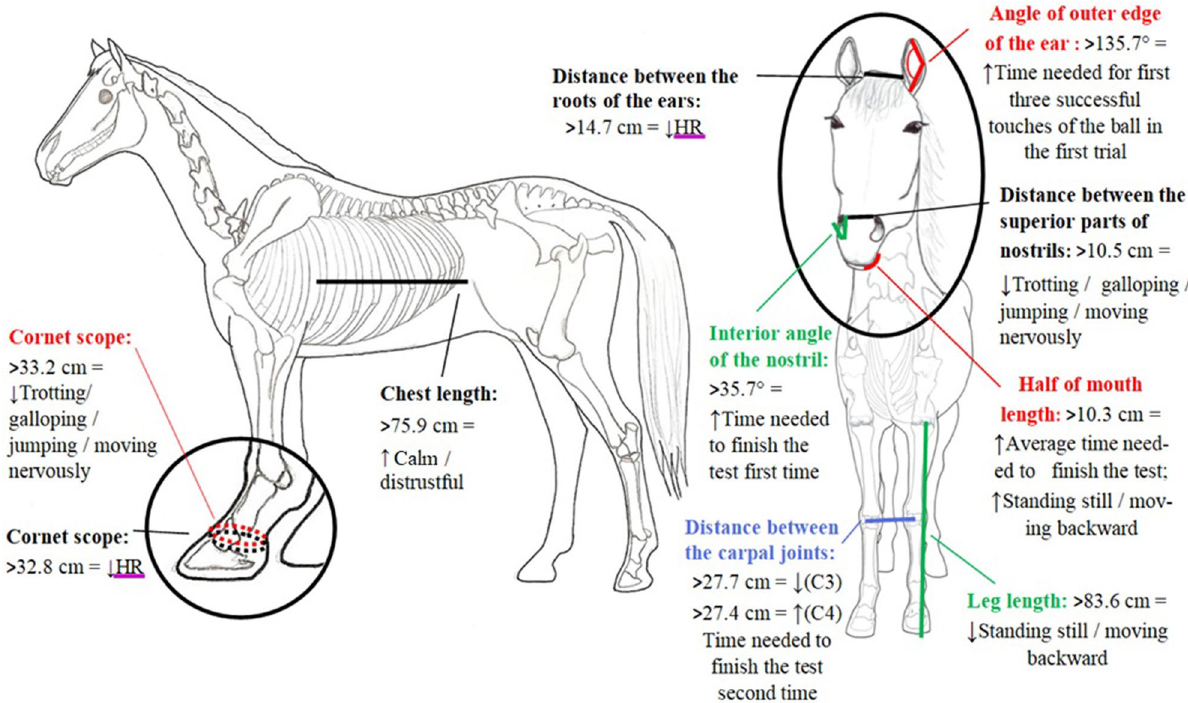
Figure 1. Anatomical measurements with only coefficient of determination for predicting behaviours and heart rate. Black line—all horses, green line—intermediate group, red line—low trainability group, blue line—low fearful group (C3) and low cooperation group (C4), purple line—relates to heart rate. ↓ ↑ —relationship between measures and behaviours or heart rate if the anatomical measurement